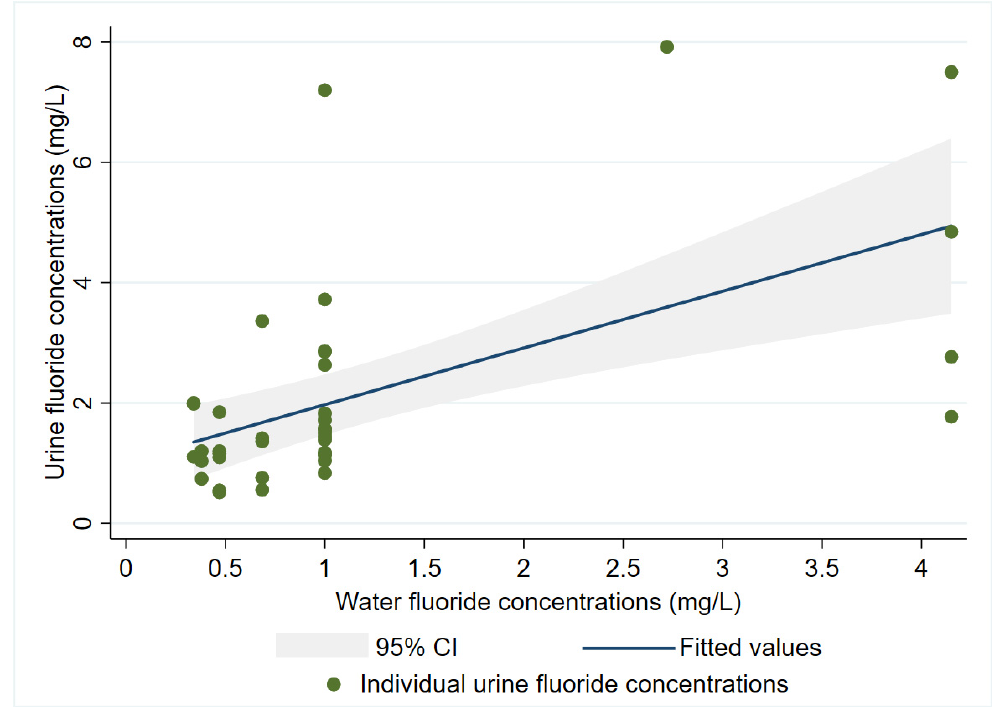
Figure 3. Urinary fluoride concentrations predicted by water fluoride concentrations and adjusted by age, sex, and BMI in 6–14-year-old children.